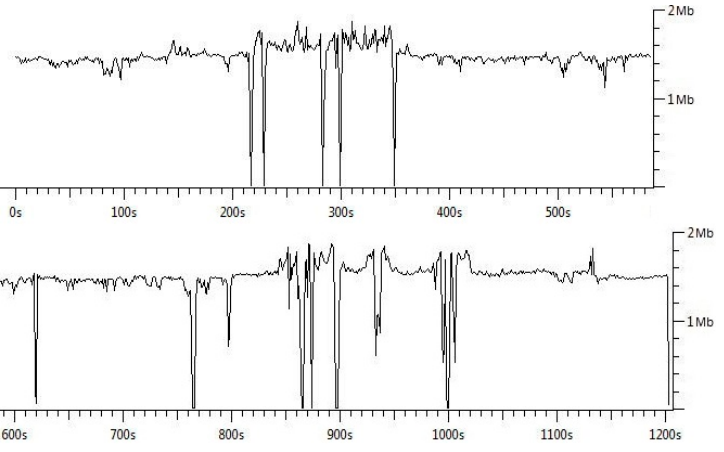
Figure 4. Data rate of vehicular networking using ITS-G5 .